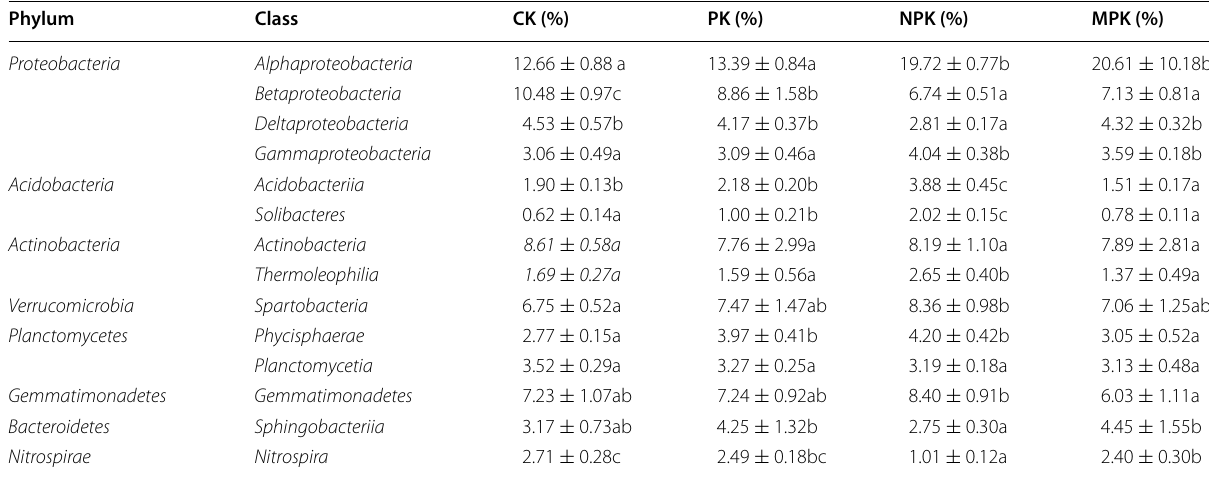
Table 4 Relative abundance of bacterial classes of different fertilization strategies (relative abundance > 1%)